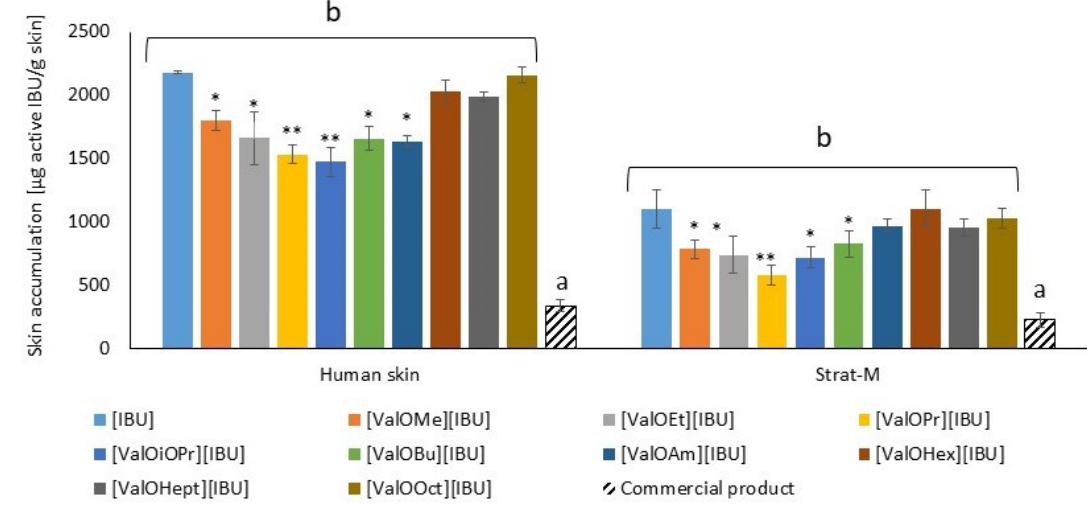
Figure 8. Skin accumulation after 24 h skin penetration of [IBU] and its modification from Celugel formulation and a commercial product. All values are presented as mean ± SD where n = 3. * p < 0.001, ** p < 0.0001 in compared unmodified [IBU]. Different letters—significant differences between Celugel ® (b) and commercial product (a).